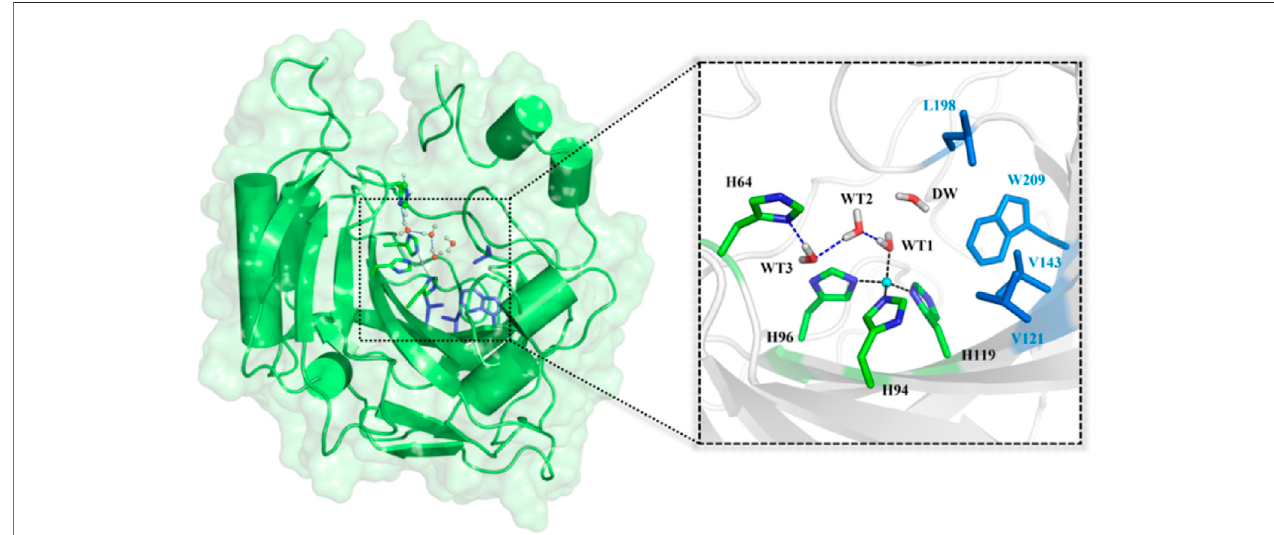
FIGURE 1 | Structures of CA and the selected active domain highlighted in the dotted box, where the zinc ion is coordinated with H94, H96, H119, and WT1, and the residues colored in blue represent the hydrophobic pocket in the active site of the equilibrated ready state of CA prepared based on the X-ray crystal structure (PDB code: 2CBA).